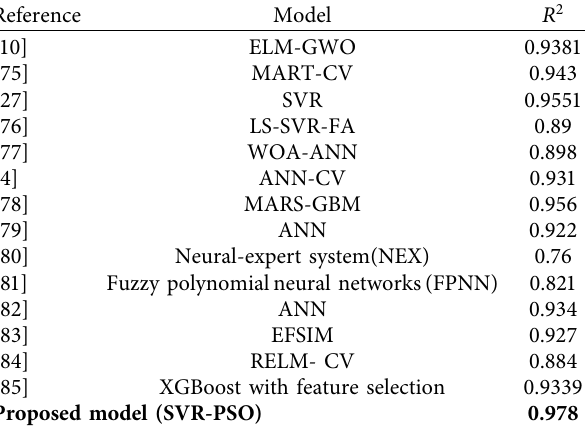
Figure 9: Sensitivity analysis results.